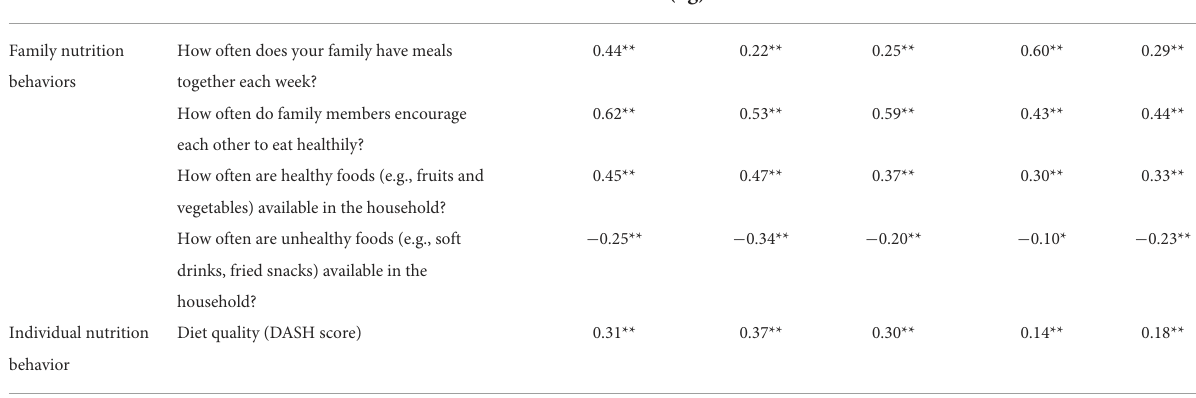
TABLE 9 Pearson’s correlations for FHC-NU (Sg) with family- and individual-level nutrition